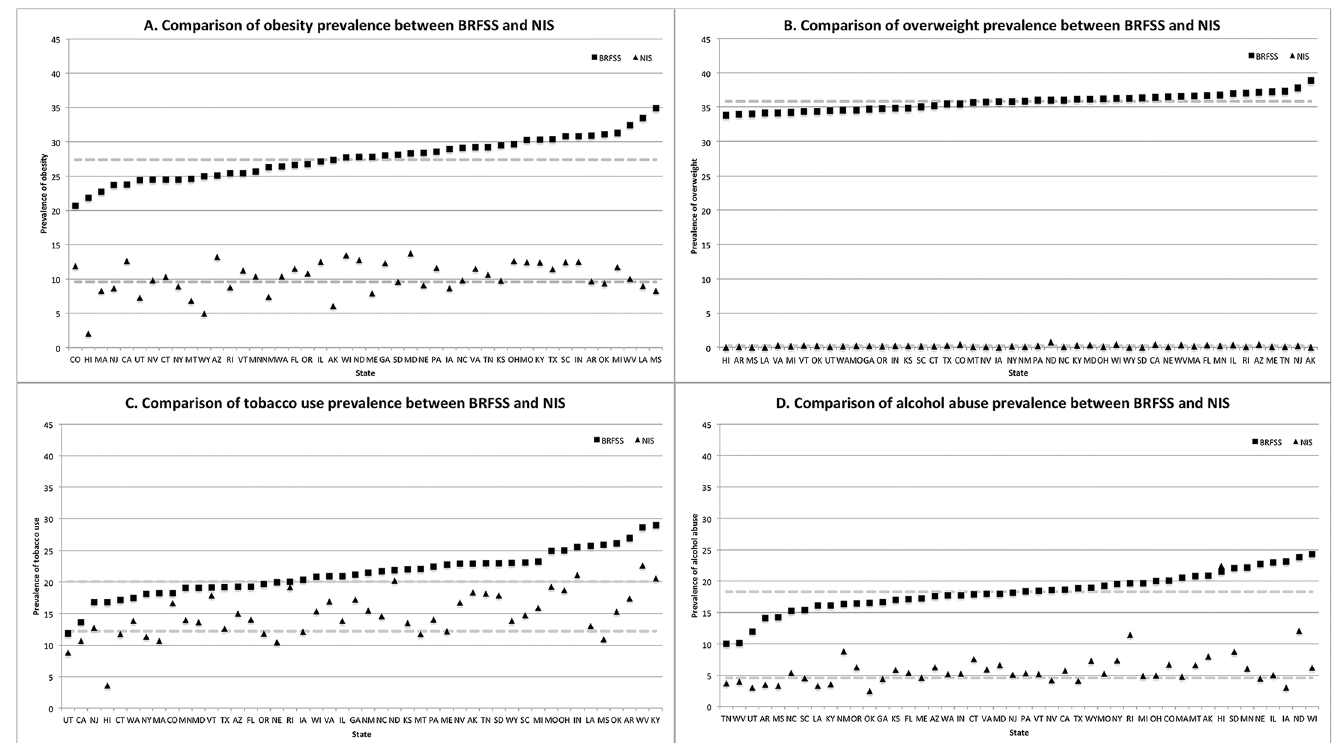
Fig 1. State-level comparisons between BRFSS and NIS in 2011. Dashed lines represent the national